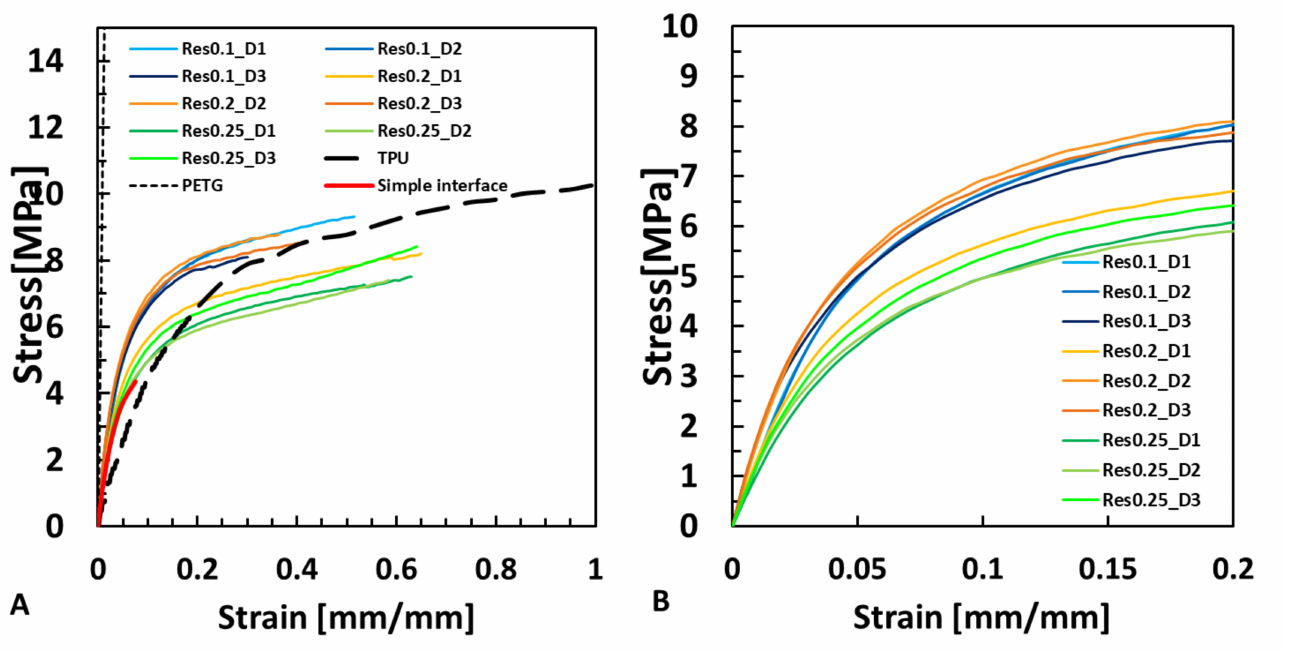
Figure 7. ( A ) The influence of the resolution (RES) and horizontal overlap distance (HOD, D) parameters on the mechanical behavior in comparison to the TPU, PETG and Simple interface. ( B ) The influence of RES and HOD in the mechanical behavior up to 0.2